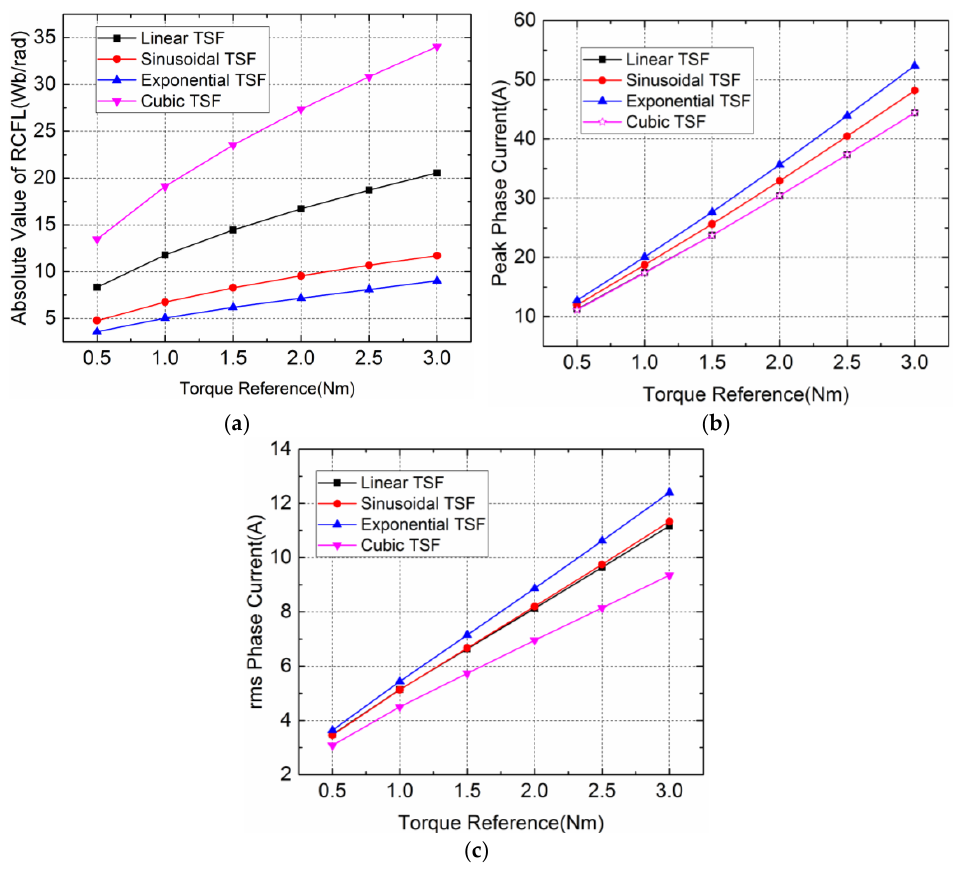
Figure 6. Comparison of four conventional TSFs: ( a ) absolute value of the rate-of-change of the flux linkage (RCFL); ( b ) peak phase current; ( c ) rms phase current.